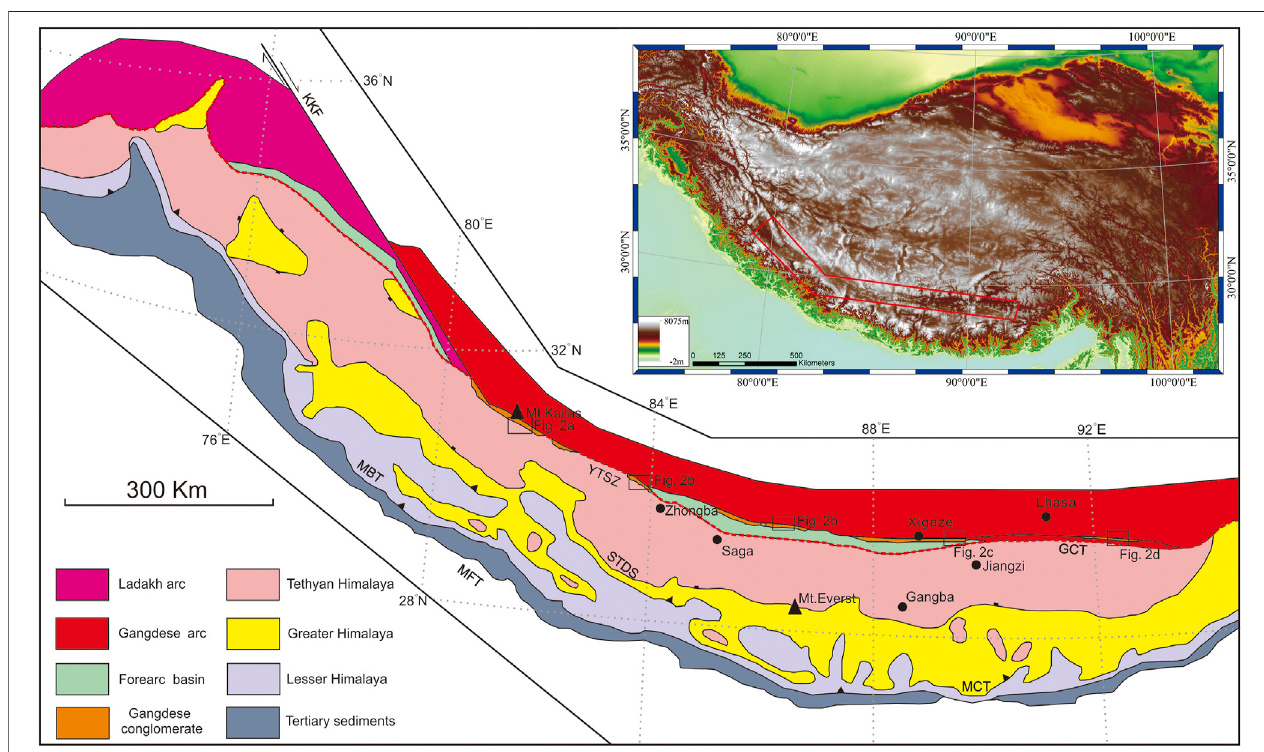
FIGURE 1 | General geologic map of southern Tibet, modi fi ed after Yin (2006). Study area is outlined in red. Major faults: MFT, Main Frontal Thrust; MBT, Main Boundary Thrust; MCT, Main Central Thrust; STDS, South Tibetan Detachment System; GCT, Great Counter Thrust; KKF, Karakoram Fault. Major sutures: YTSZ, Yarlung-Zangbo suture